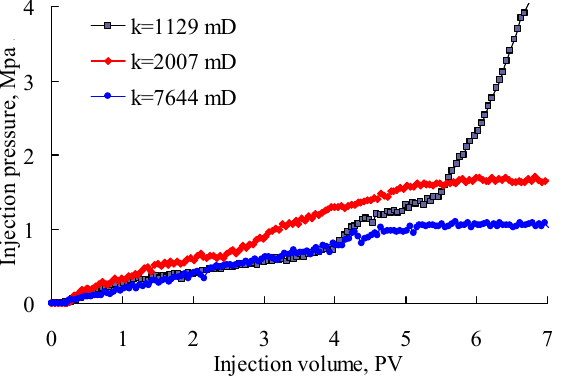
Figure 2. Injection pressure of PPG (80–100 mesh; 2–4 Pa) versus injection volume.